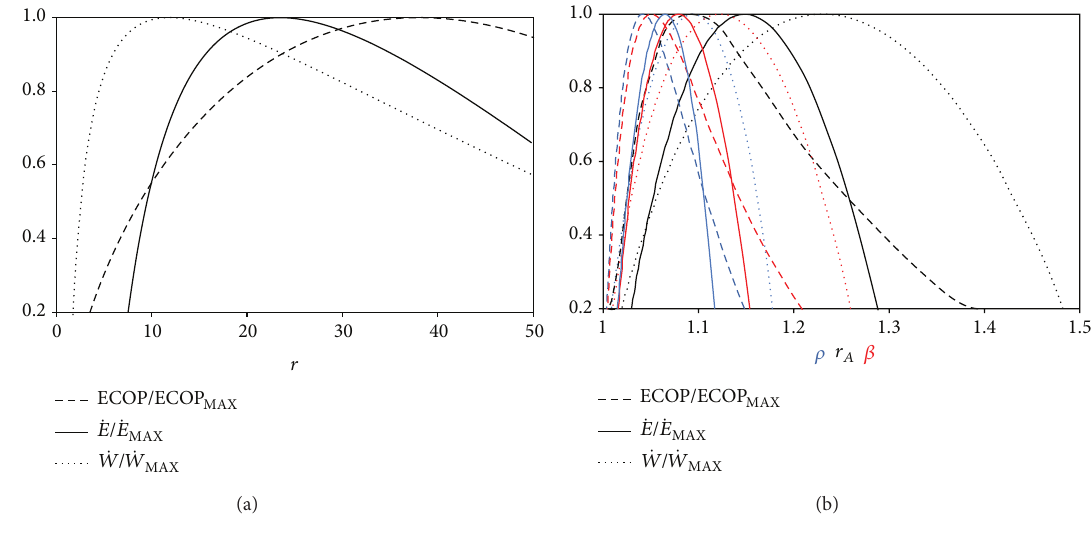
̇𝑊 Figure 6: Normalized ECOP ˙E and versus (a) 𝑟 and (b) 𝜌 , 𝑟 𝐴 , 𝛽 ( 𝑇 0 = 𝑇 𝐿 = 300 K, 𝜏 = 7 , 𝐼 Δ𝑆 = 1.2 , 𝑋 = 0.3 , and 𝜉 = 0.02 ).